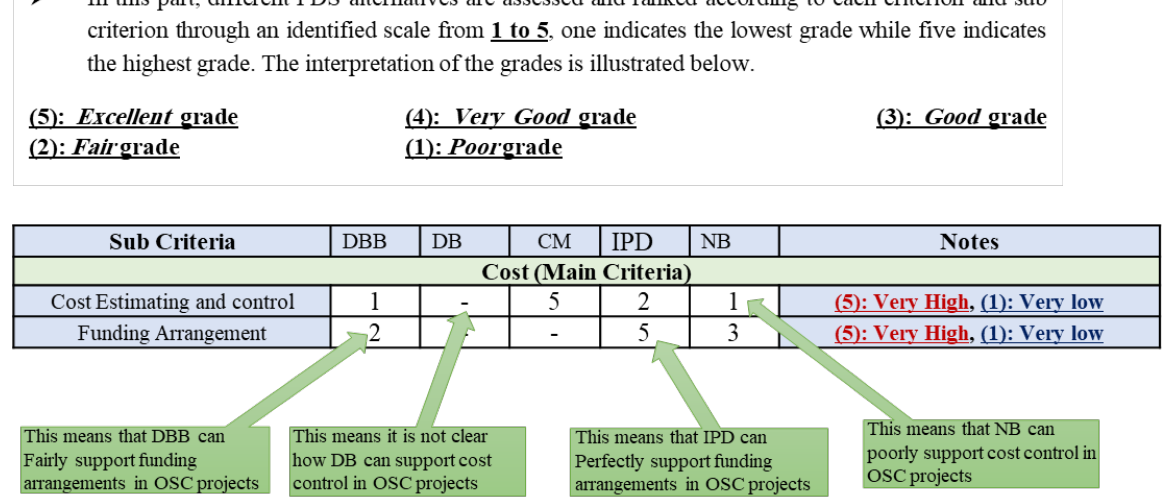
Figure 7 . Instruction provided for part 4 of the questionnaire .